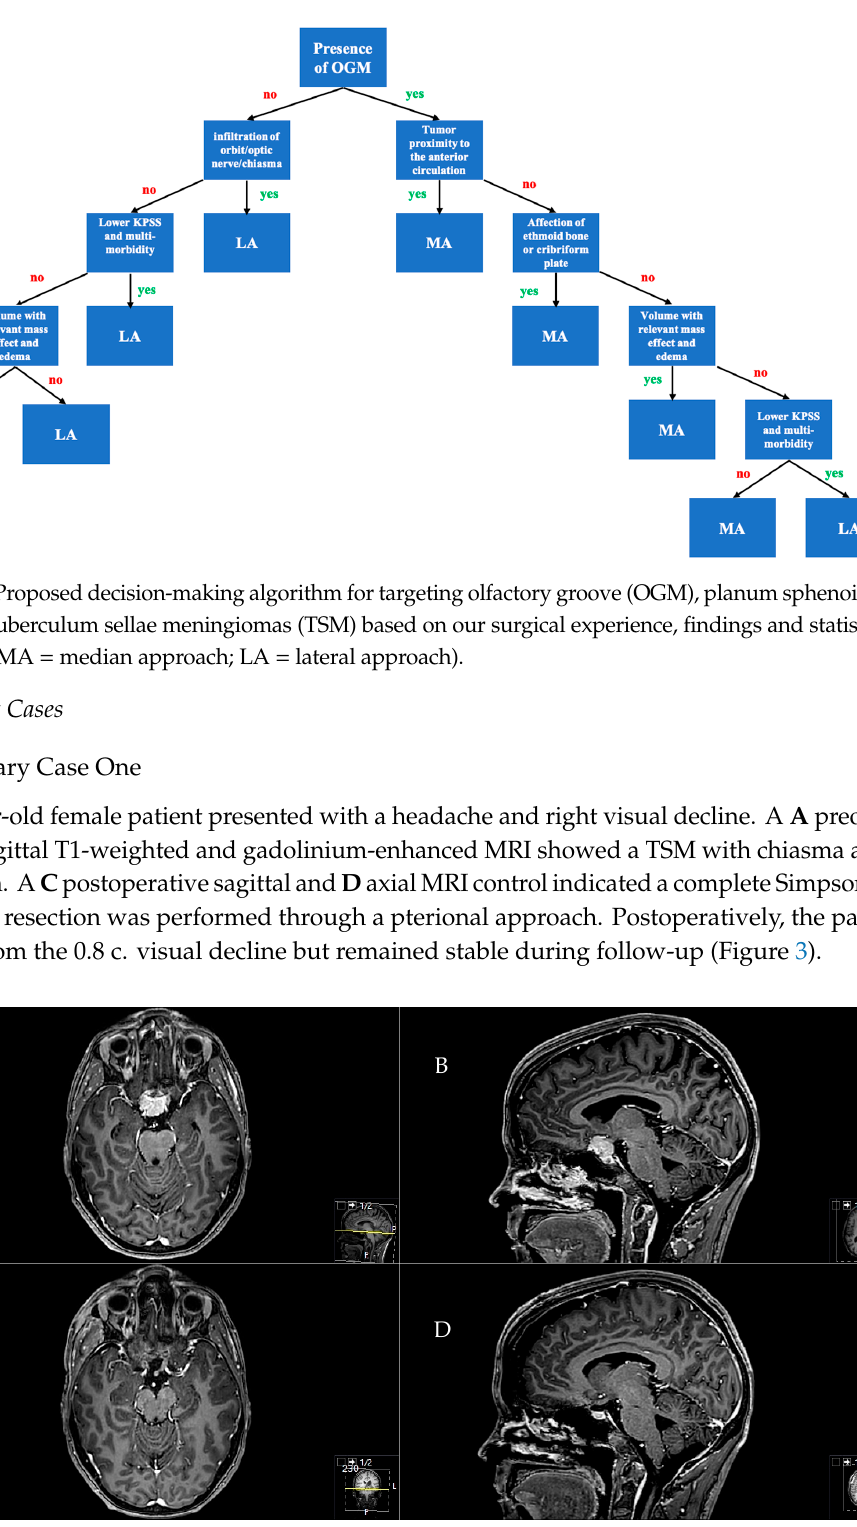
Figure 3. Exemplary case of a TSM with visual affection.